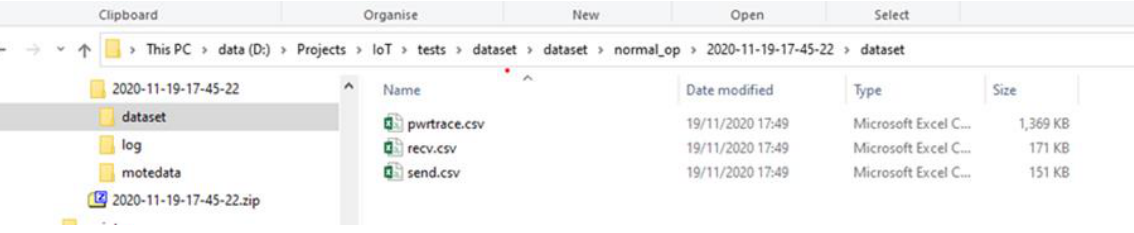
Figure 9. Location of the generated “pwrtrace.csv”, “recv.csv”, and “send.csv” f iles by the “IoT_Simul.sh” file .